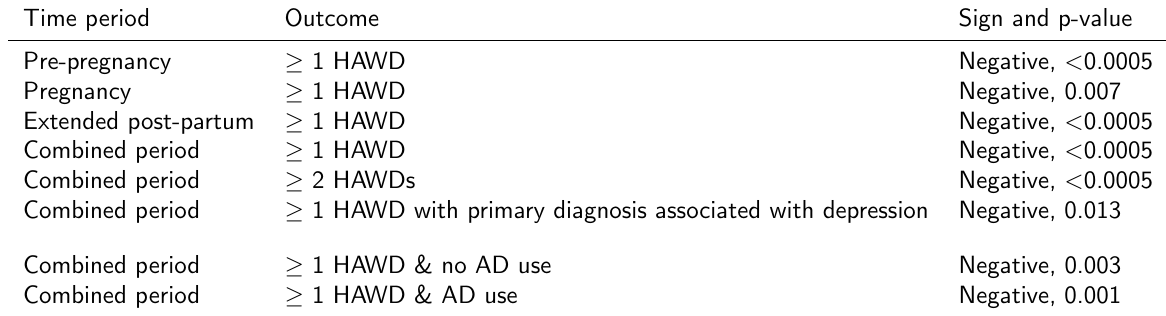
Supplementary table 2: Linear trends of outcome measures over increasing